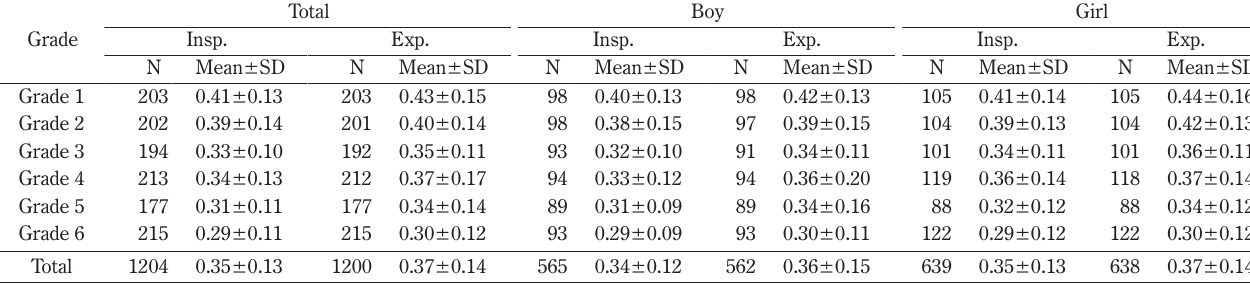
Table 1 Bilateral nasal resistance in normal children and grades of elementary school Grade